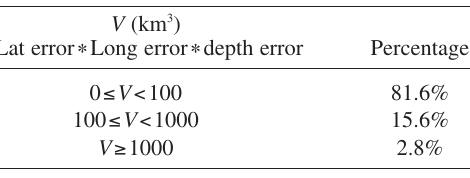
Table I. Evaluation of the error associated to hypo- central locations. The percentage only considers the events whose depth is not fixed.